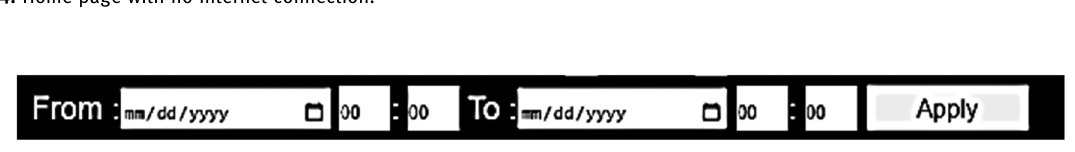
Figure 4: Home page with no internet connection.